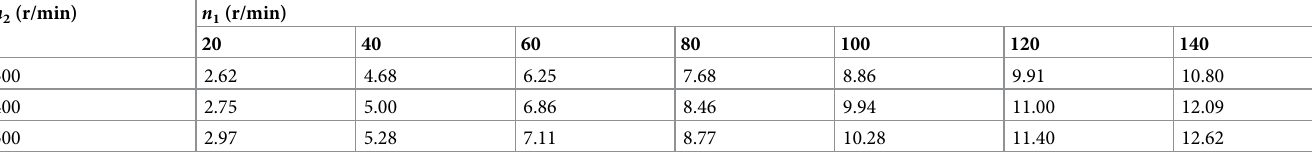
Table 7. Sand productivity of scheme